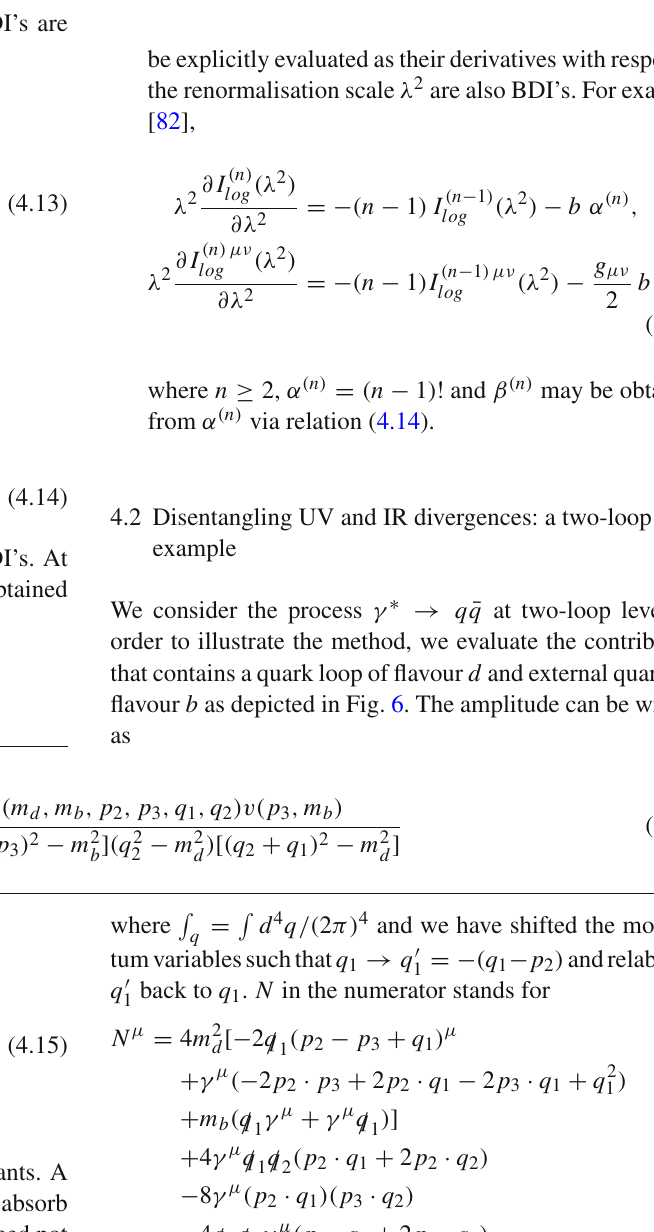
Fig. 6 N F two-loop Feynman diagram for γ ∗ → b ¯